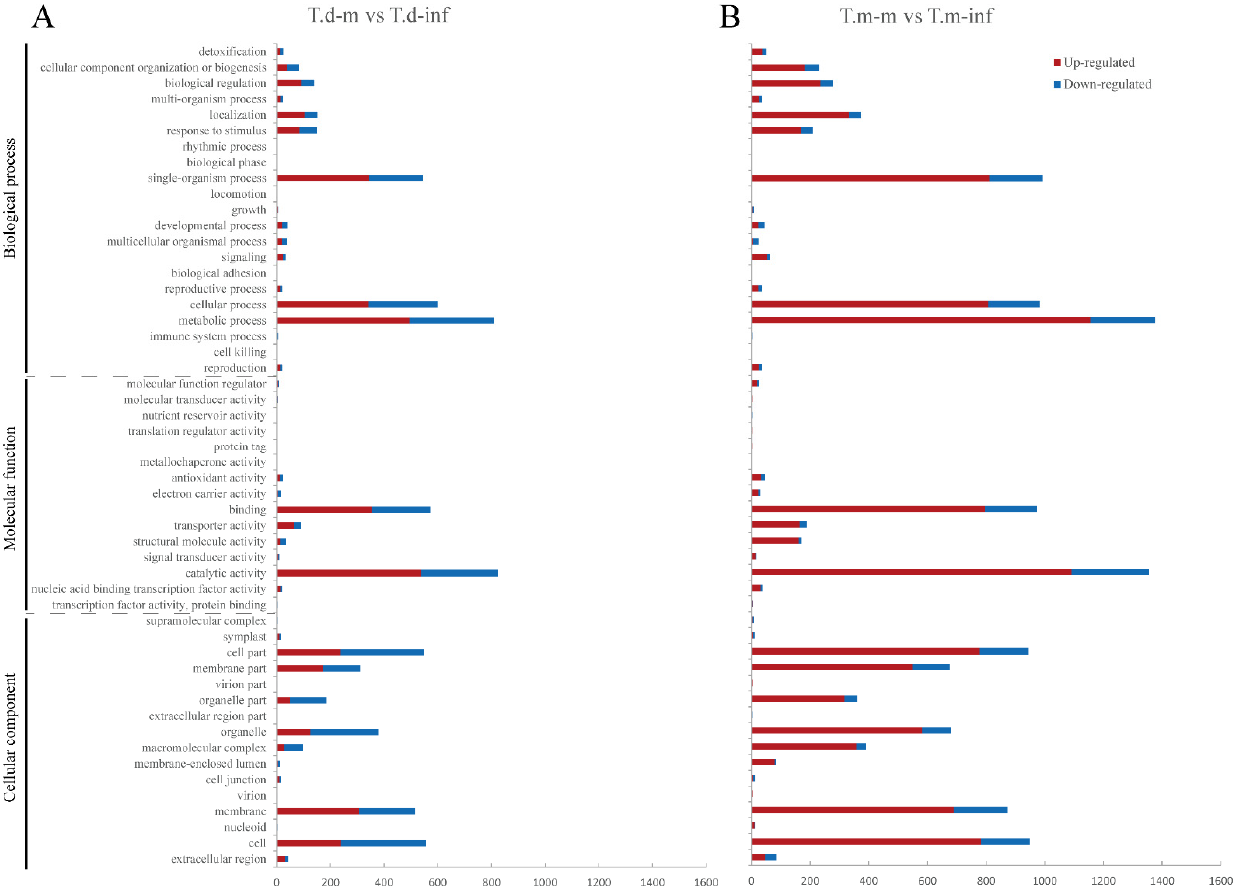
Figure 4. Gene ontology (GO) analysis of up- and downregulated DEGs, respectively, in T. distichum and T. mucronatum . Merging groups of significant GO enrichment in T. distichum ( A ) and T. mucronatum ( B ).